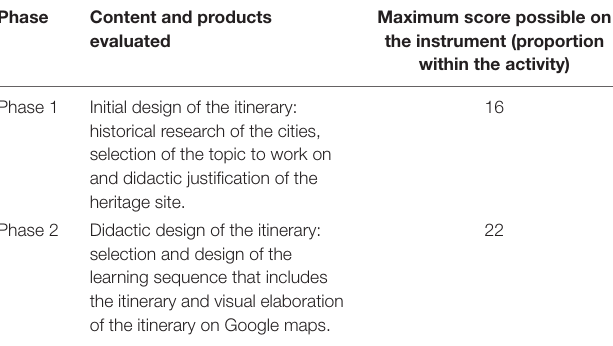
TABLE 2 | Synthesis of the assessment scale in phases 1 and